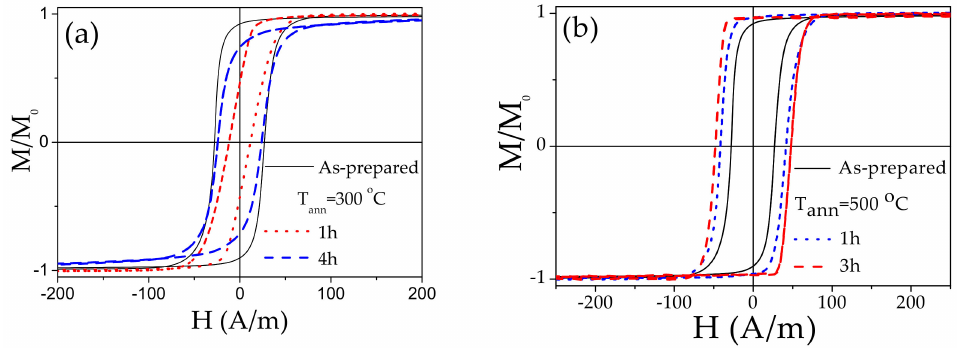
Figure 11. Hysteresis loops of as-prepared and annealed at 300 ◦ C ( a ) and 550 ◦ C ( b ) Fe 71.7 B 13.4 Si 11 Nb 3 Ni 0.9 glass-coated microwires. Adapted from ref. [45].